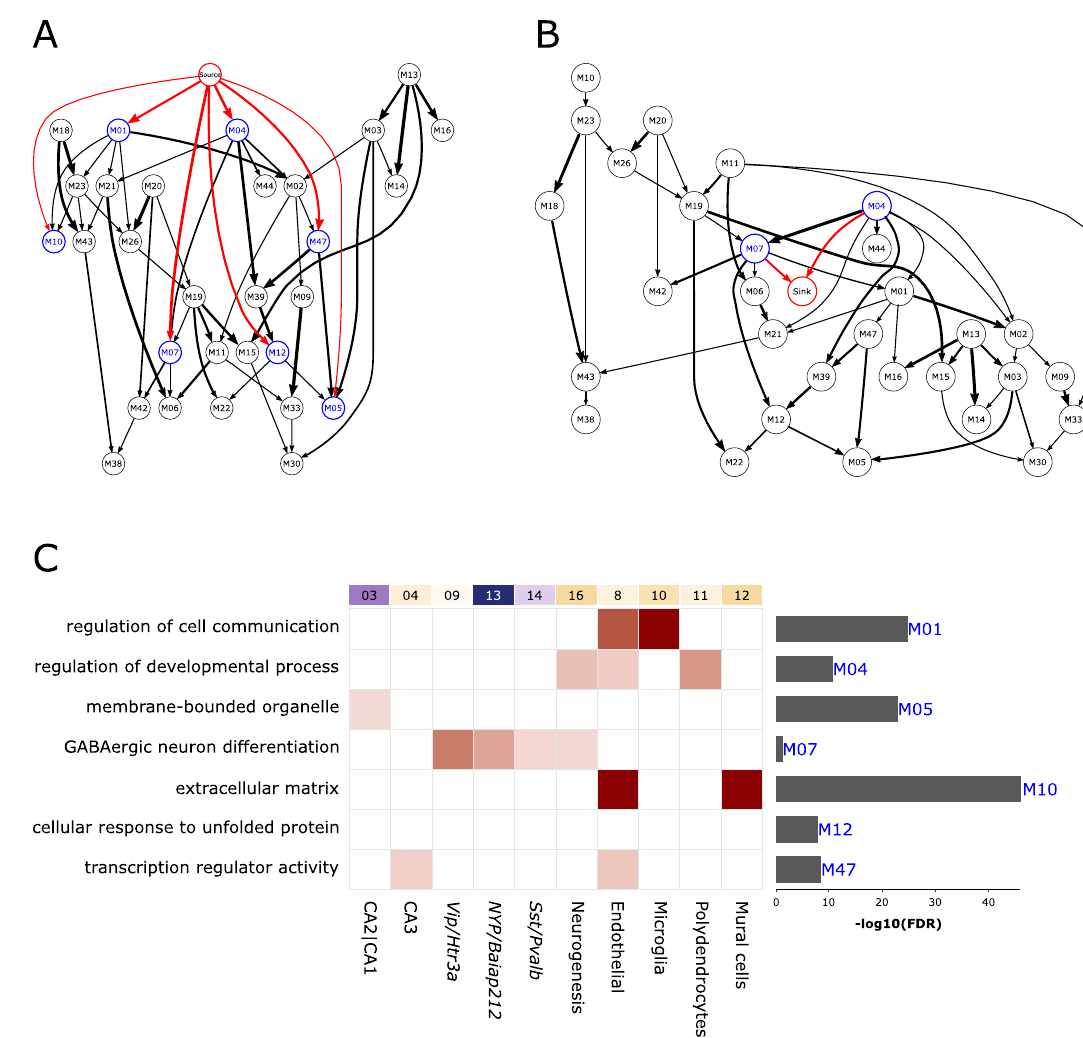
Figure 4. Prioritizing the TLE-associated upstream (putative causal) and downstream (putative consequential) gene modules using a Bayesian network. ( A , B ) Directed acyclic graph obtained after fitting the Bayesian network to the eigengenes of consensus WGCNA modules, shown as nodes. The edges represent probabilistic dependencies between the nodes from early to later (referred as parent-to-child) associations. Source and sink nodes constitute a categorical variable represented by sample labels (i.e., control and epileptic). Source node ( A ) has no parent node but has child nodes representing downstream consequential gene modules connected to it (in blue with red edges). In turn, the sink node ( B ) has no child nodes but has parent nodes representing upstream causal gene modules connected to it (in blue with red edges). Note that the M04 and M07 nodes are associated with both source and sink nodes. The thickness of the edges corresponds to the number of times (in percent) the edges were detected in the 1000 permutations used to generate the Bayesian network. ( C ) Characterization of source- and sink-associated nodes using gene ontology (GO) and cell type (from Fig. 2). Enriched GO terms are shown on the left, with significance shown as a bar graph on the right. Enrichment of cell-type clusters (top labels, same as Fig. 2C) in genes of up- and downstream nodes. The lighter-to-darker shades of pink indicate increasing significance of cell-type Taken together, these results showed that the Bayesian network organized the biological events observed across control and epileptic samples into a coherent and directional graph. Although these events occurred in the context of TLE, the direct association of the source and sink nodes with seven DAG nodes suggests that cell communication, GABA neuron differentiation, extracellular matrix, and transcription regulation are more proximal and potentially causal or consequential with respect to TLE. Moreover, the cell-enrichment analyses of nodes M04 and M07, which were found both in the source and sink DAGs, implicate that the interaction between nonneuronal cells and GABAergic interneurons are potential mediators of the identified causal and consequential events in TLE. Known epilepsy drugs and related targets are associated with the source‑ and sink‑associated nodes. We hypothesized that, if the up- and downstream nodes are directly associated with the epileptic